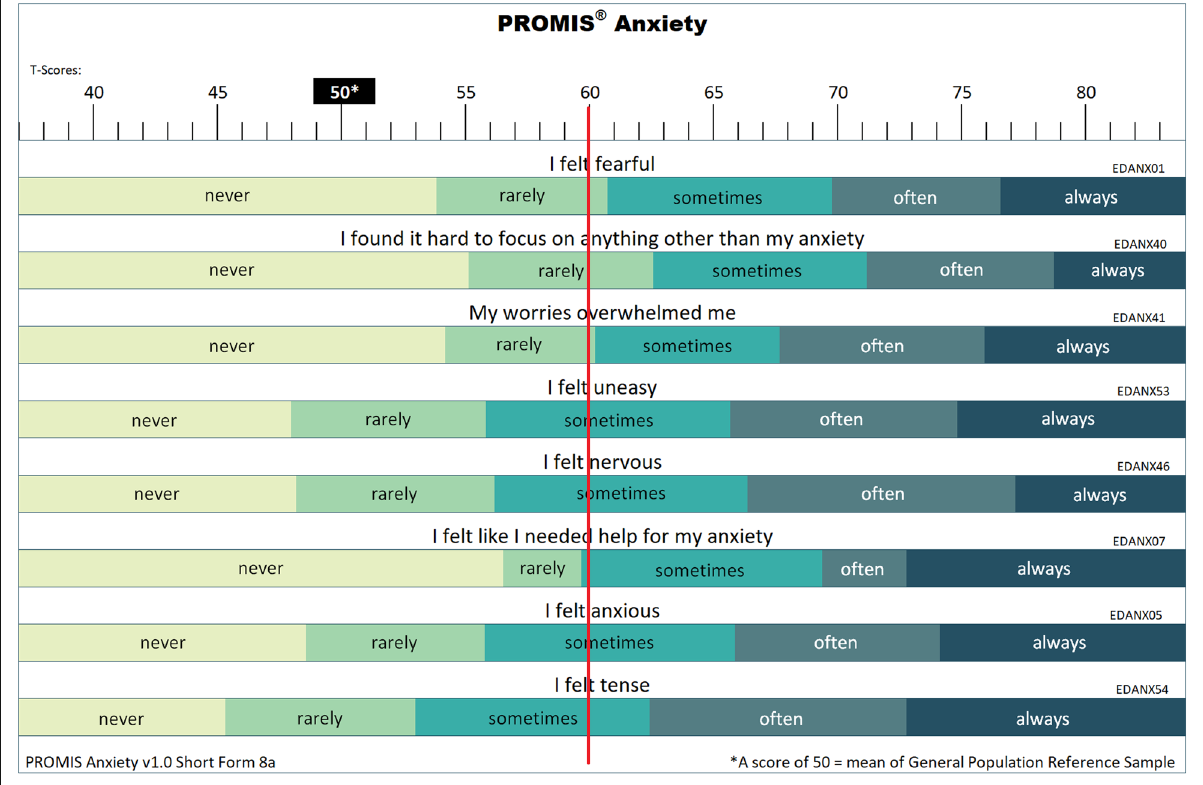
Fig. 1 T-score Map for PROMIS Anxiety Short Form 8a with reference line for T-score of